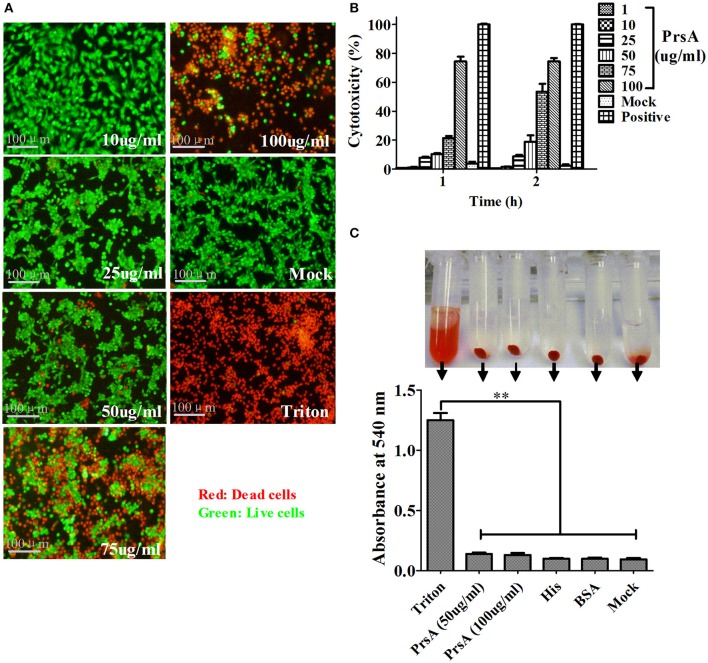
PrsA protein showed dose-dependent cytotoxicity but without hemolytic activity. (A) Fluorescent observation of live (green) and dead (red) bEND3.0 cells treated with PrsA at different concentrations for 1 h. Triton X-100 (0.2%) and 1640 medium treatments were used as positive and negative controls. Bar scales indicated were 100 μm. (B) Evaluation of cytotoxicity with lactodehydrogenase (LDH) release assay kit. Cells were treated as panel A for 1 h or 2 hs. (C) Hemolysis analysis with 2% sheep red blood cells treated with PrsA (50 and 100 μg/ml) for 1 h at 37°C. Triton X-100 (0.2%), His-tag (100 μg/ml) and BSA (100 μg/ml) proteins were used as controls. Absorbance values of the supernatant samples from the above treatments were measured at 540 nm. Data were shown as mean ± SD of three replicate wells of each treatment. **Indicated significant at P < 0.01.